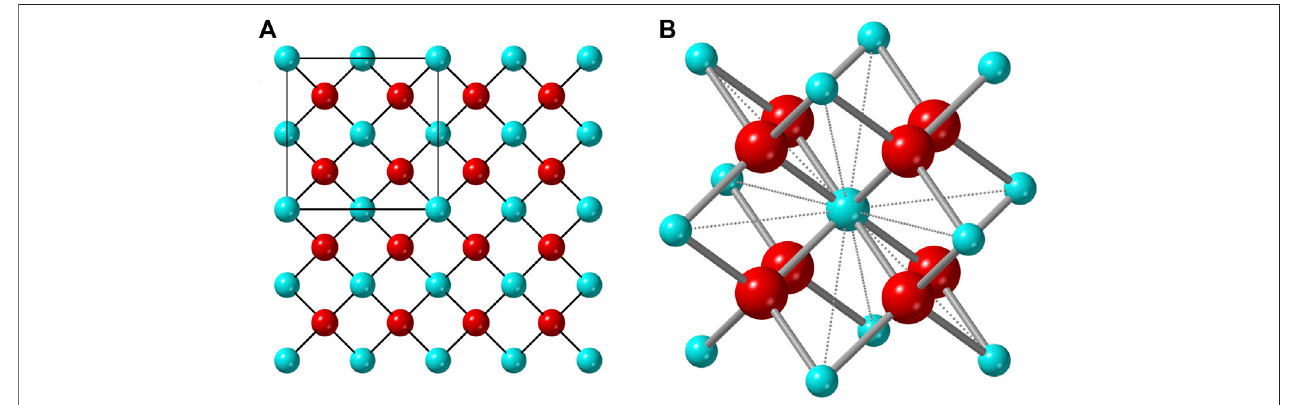
FIGURE 1 | (A) Atomistic representation of the ideal fl uorite structure with the unit cell denoted by the square in the upper left corner. (B) The cube-octahedron represented by a polyhedron formed by twelve vertices occupied by cations (blue) and the nearest eight anions (red) to the central cation (same for any other cation).